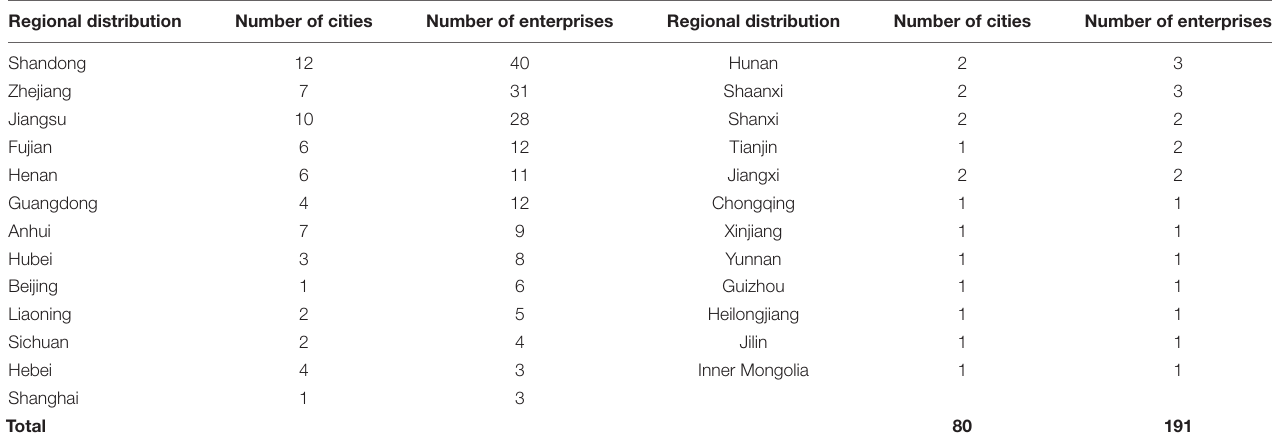
TABLE 2 | Regional distribution information on